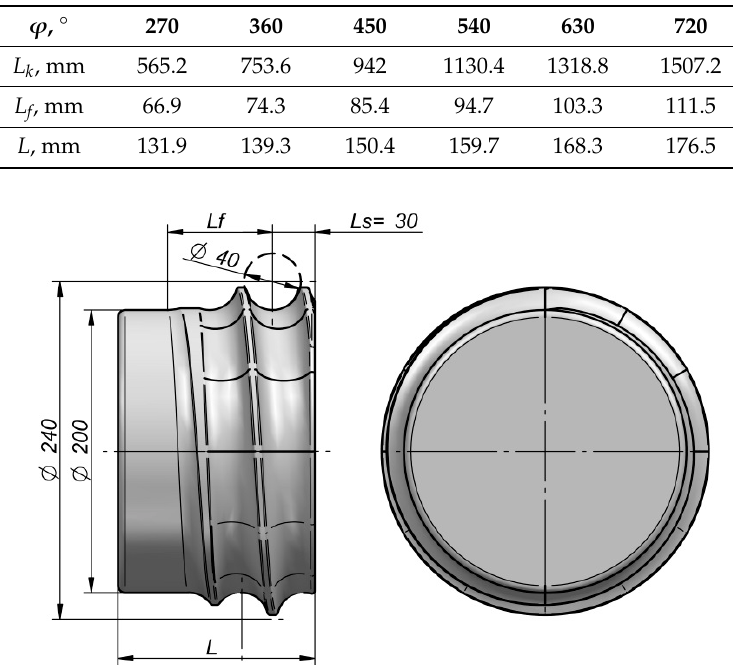
Figure 8. View of the helical tool (defined by ϕ = 360°) used in a numerical analysis, and its selected dimensions.